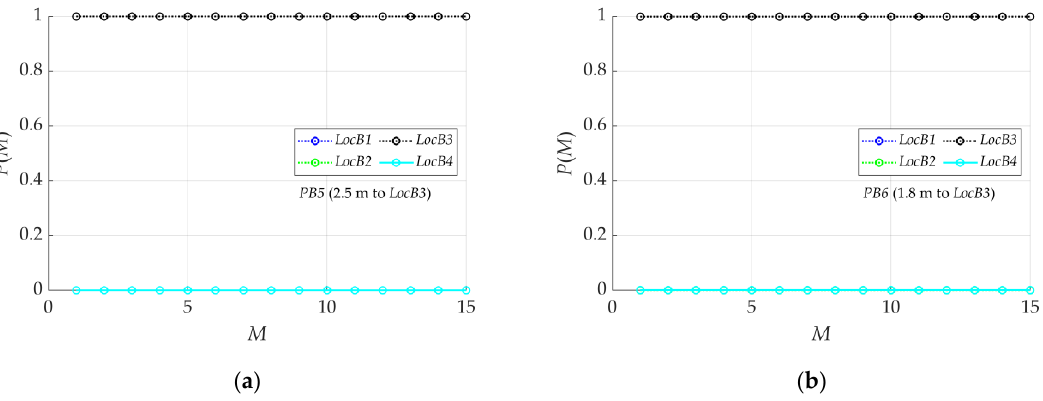
Figure 20. Probability of detecting each of the locator nodes depending on the width M of the moving window for an object located at a distance of 1.8 m from the receiver: ( a ) LocB3 (location PB3 ); ( b ) LocB4 (location PB4 ).